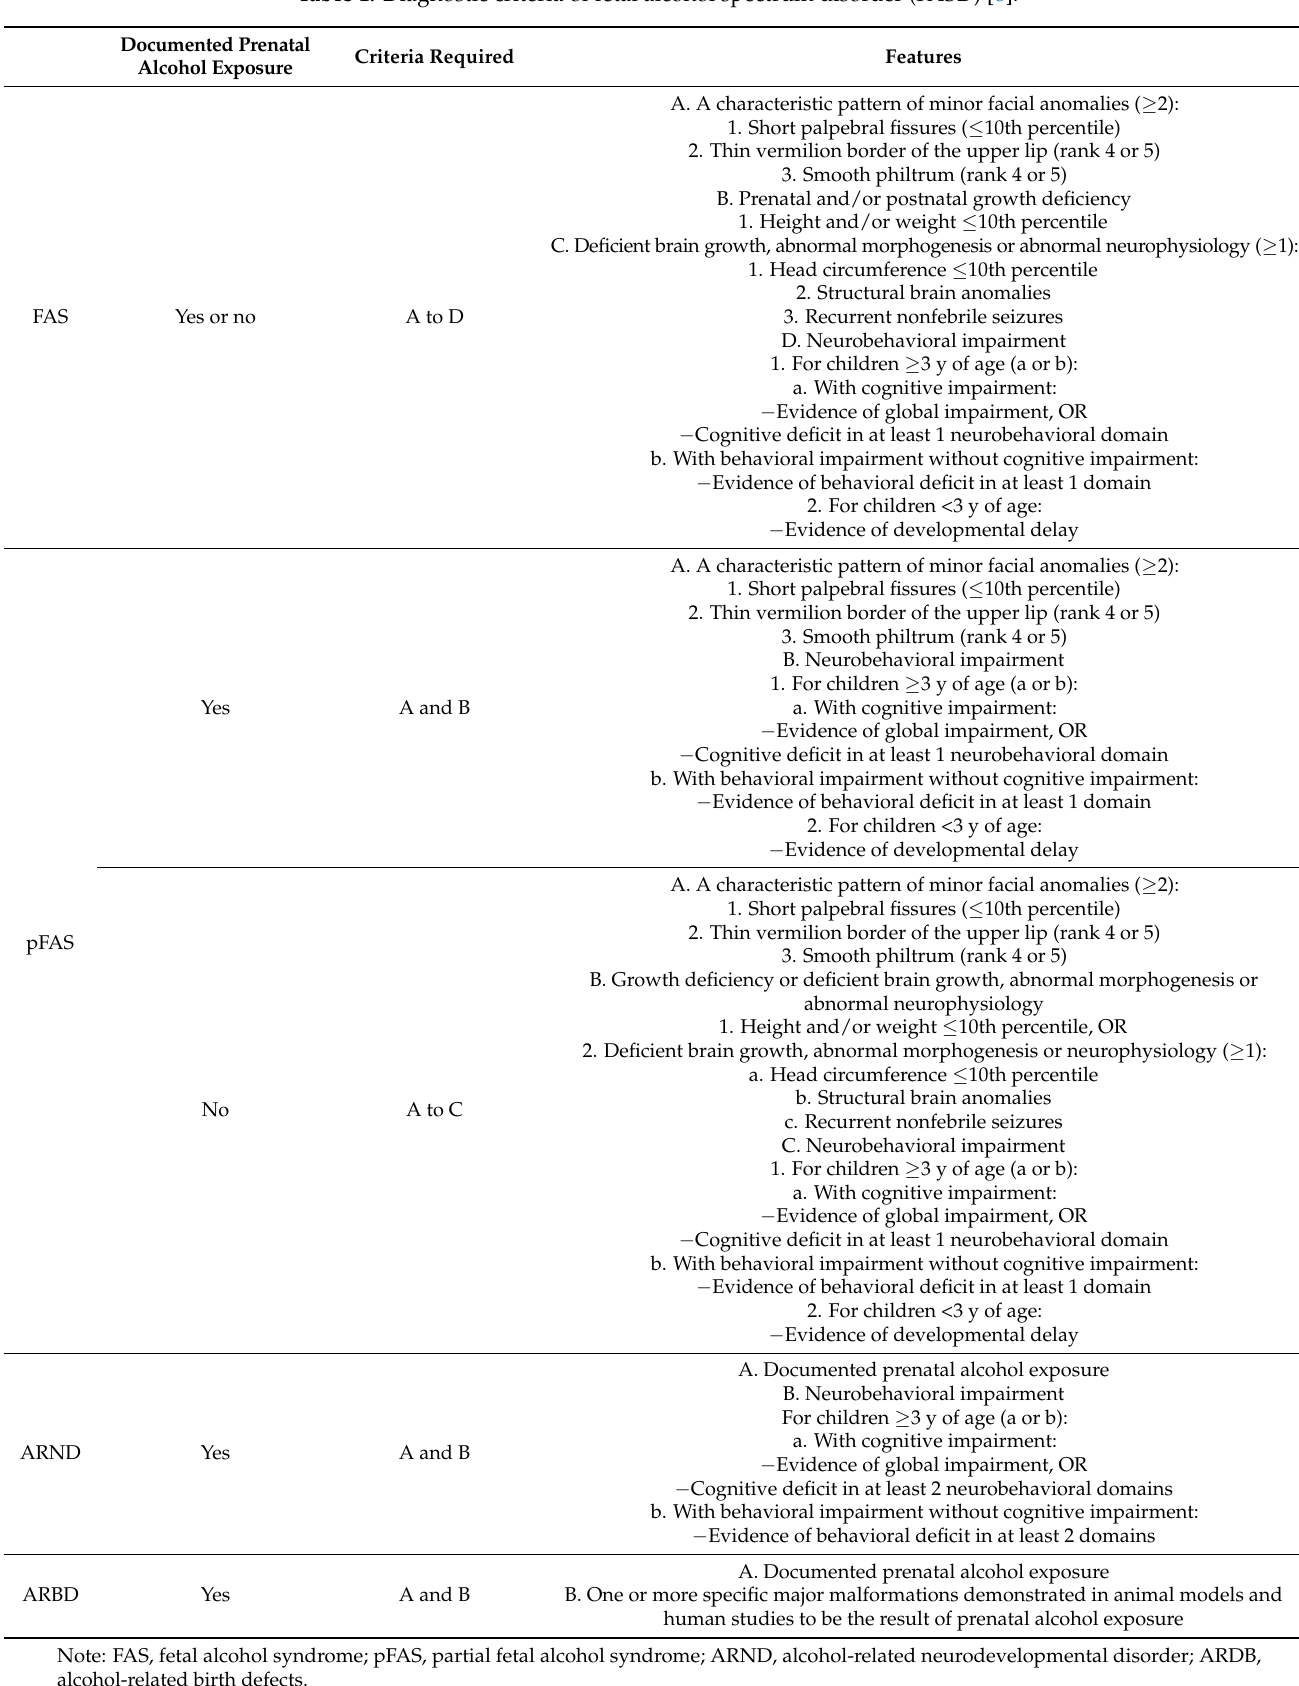
Table 1. Diagnostic criteria of fetal alcohol spectrum disorder (FASD)